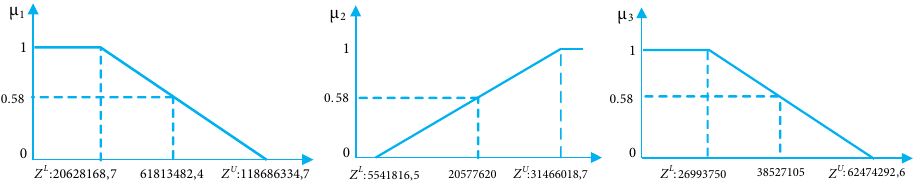
Fig. 3. Optimal objective values and membership function